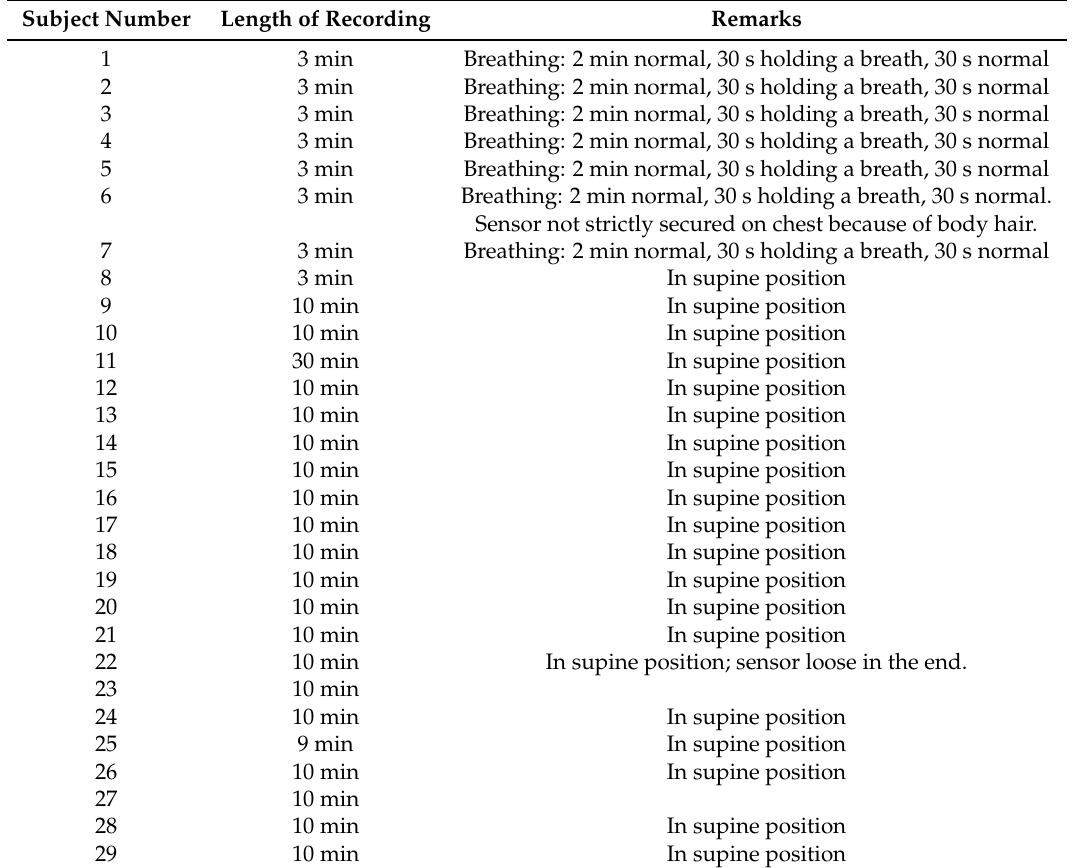
Table 1. Recording